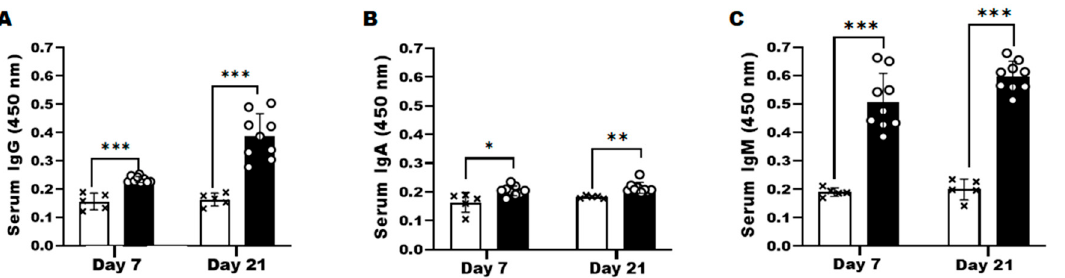
Figure 5. Evaluation of anti- Acanthamoeba IgG, IgA, and IgM antibodies in sera. The sera of the AK mouse model were collected after 7 and 21 dpi with A. castellanii and anti- Acanthamoeba serum IgG ( A ), IgA ( B ), and IgM ( C ) were observed by ELISA. Negative ( × ); naïve sera, positive ( ○ ); AK-mouse sera. Data are expressed as mean ± SD and asterisks denote statistical significance between the means of the two groups (* p < 0.05, ** p < 0.01, and *** p < 0.001).